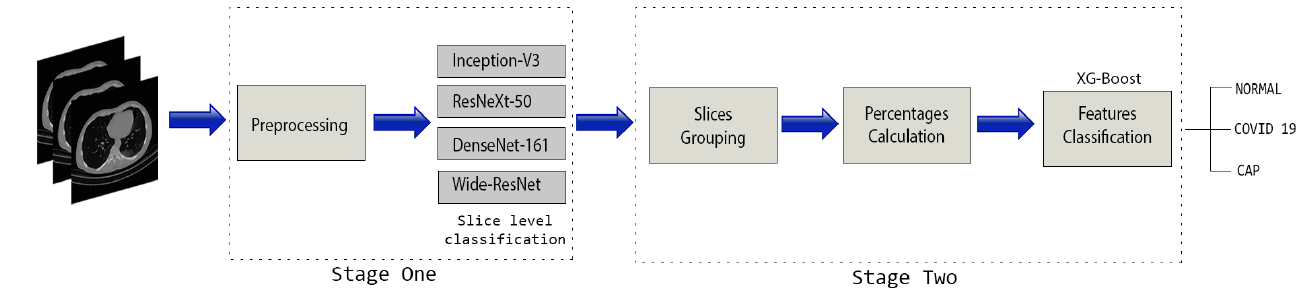
Figure 2. The overall structure of our proposed CNR-IEMN approach